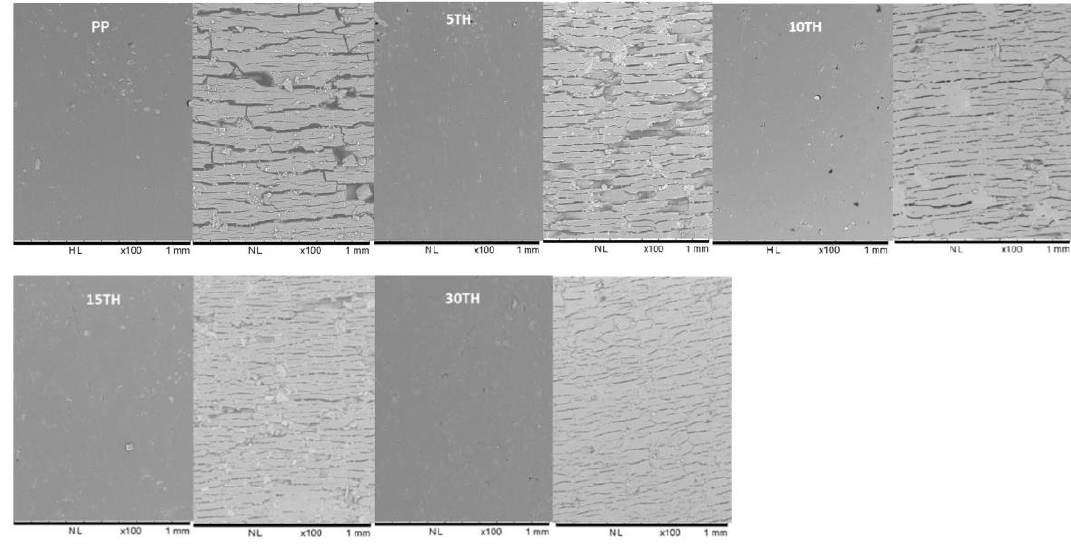
Figure 6. SEM microscopy of PP and PP/TH composites before (left) and after (right) UV weathering.